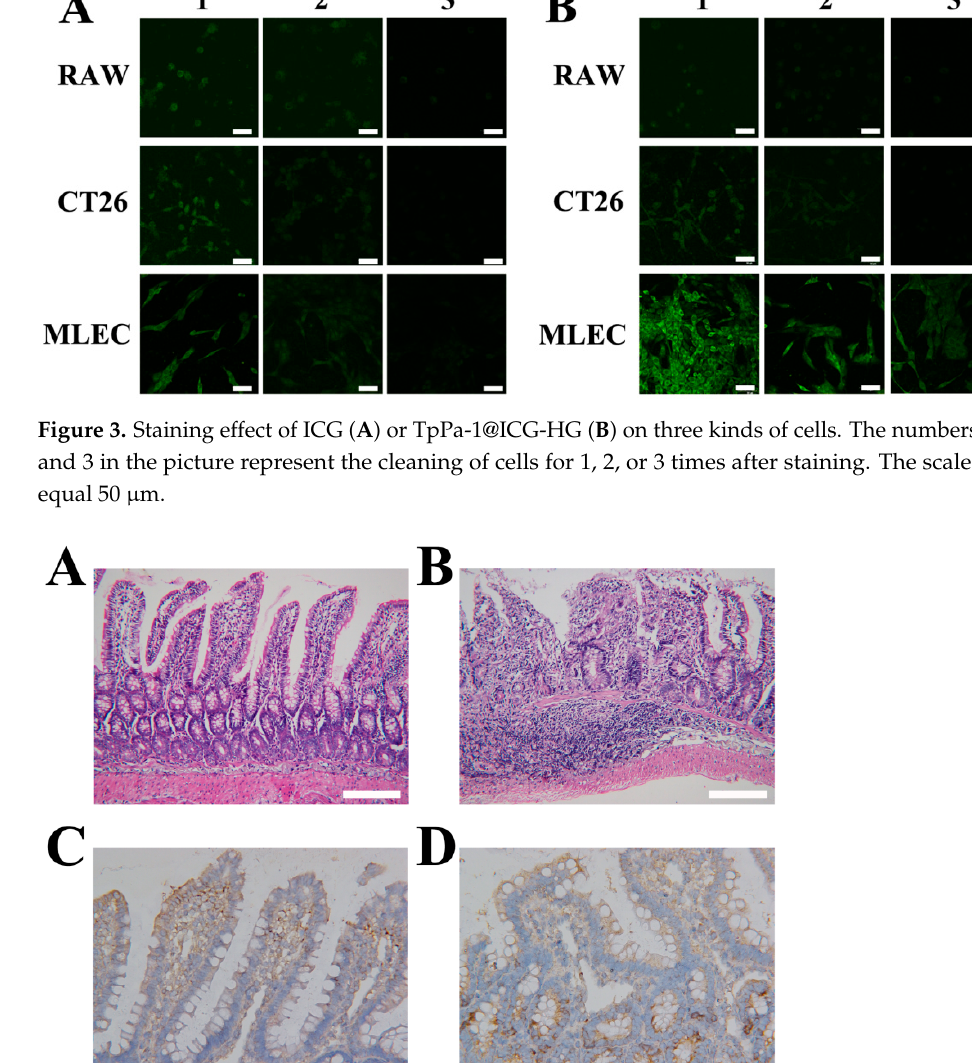
Figure 3. Staining effect of ICG ( A ) or TpPa-1@ICG-HG ( B ) on three kinds of cells. The numbers 1, 2, and 3 in the picture represent the cleaning of cells for 1, 2, or 3 times after staining. The scale bars equal 50 μ m.